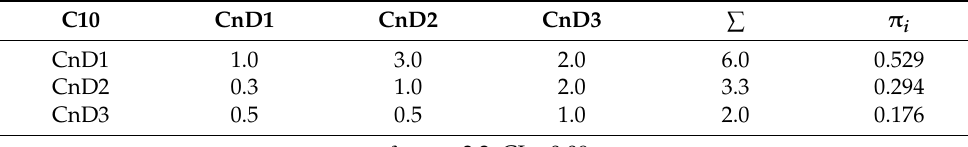
Table 14. Matrix of